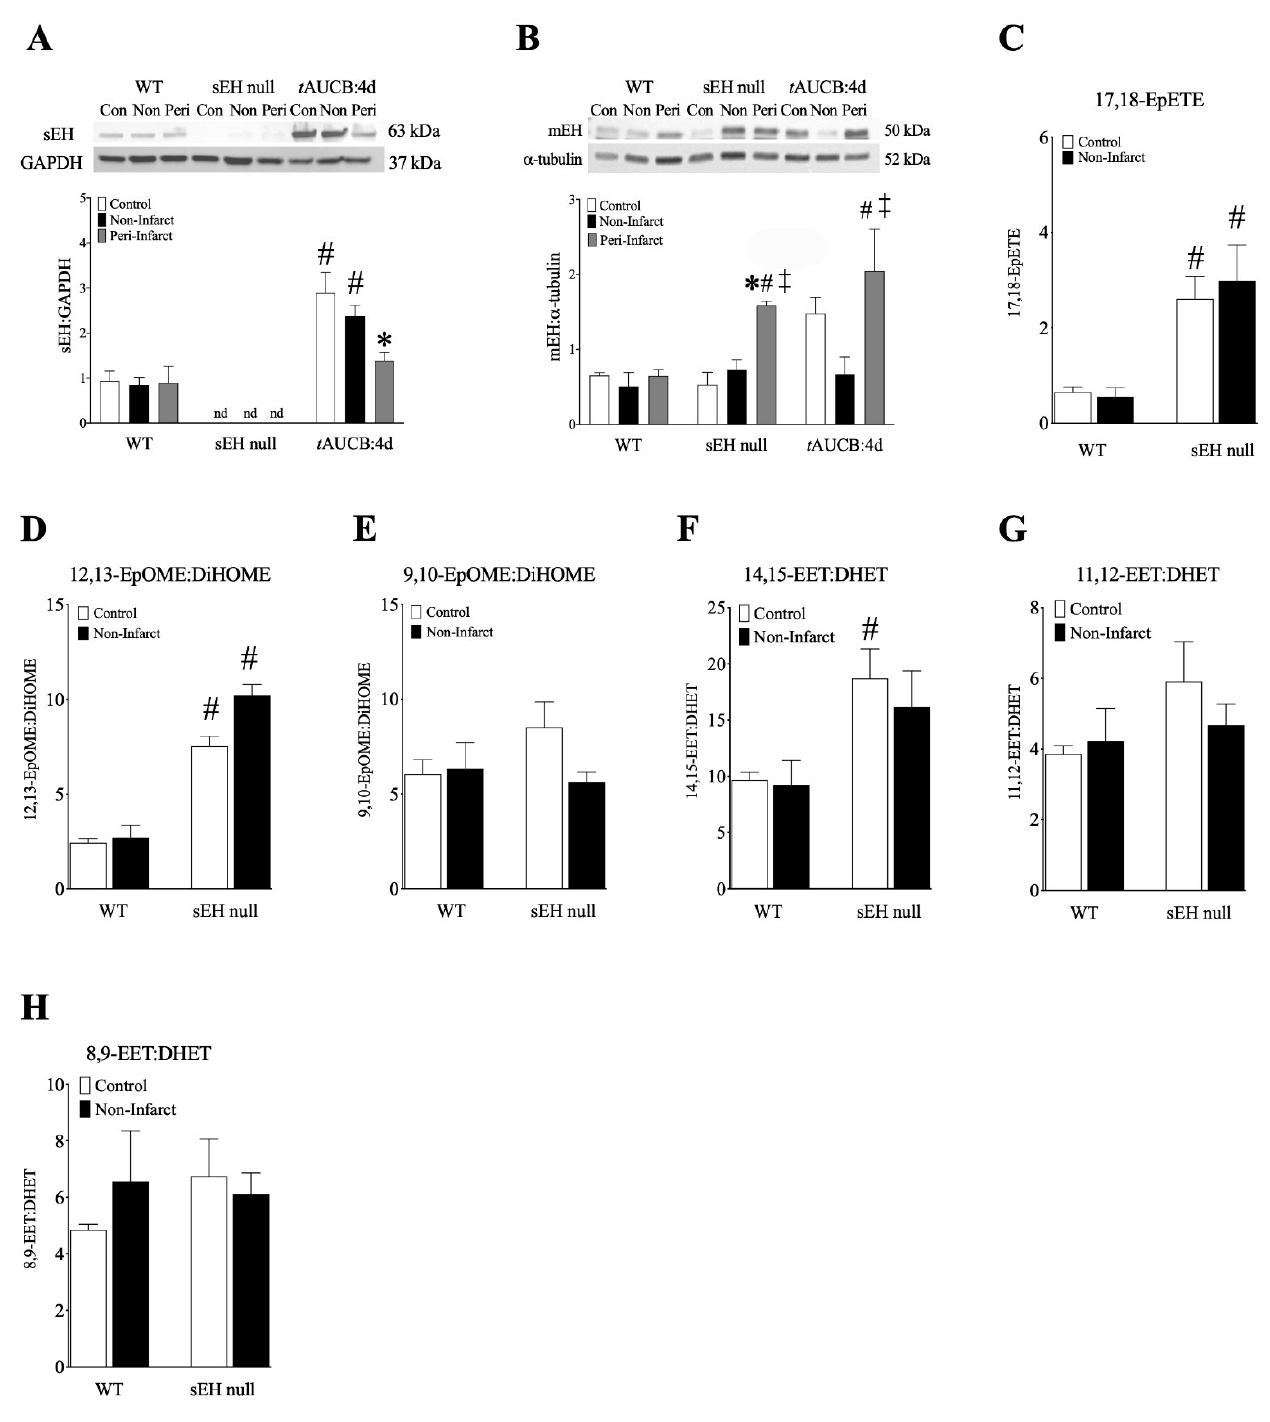
Figure 3. Epoxide hydrolase expression and oxylipid metabolites (ng/g tissue) in female mouse left ventricular tissue. ( A ) sEH expression normalized to GAPDH, and ( B ) mEH expression normalized to α -tubulin in control, non-infarct, and peri-infarct regions of female WT, sEH null, and WT+tAUCB:4d hearts at 28 days post-MI. ( C ) 17,18-EpETE, ( D ) 12,13-EpOME:DiHOME ratios, ( E ) 9,10-EpOME:DiHOME ratios, ( F ) 14,15-EET:DHET ratios, ( G ) 11,12-EET:DHET ratios, ( H ) 8,9-EET:DHET ratios. Data are mean ± SEM, n = 3–6. In all cases, p ≤ 0.05, * vs. control group; # vs. WT group; ‡ vs. non-infarct group.